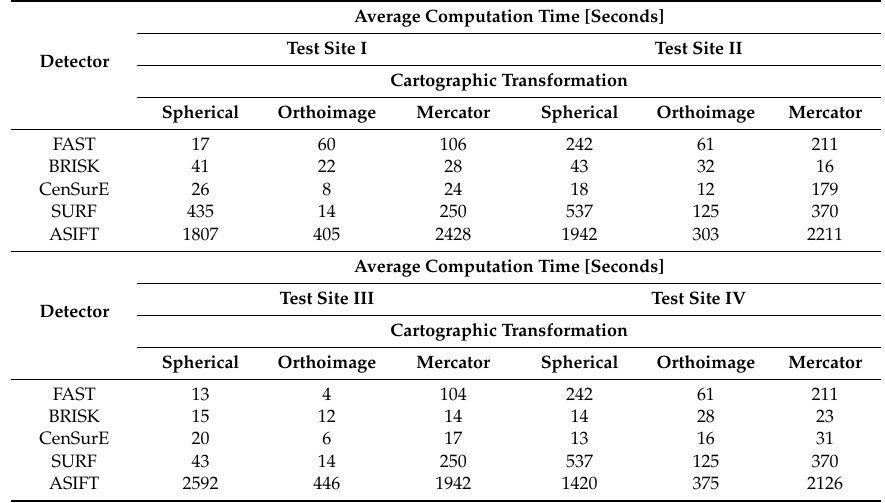
Table 1. Time taken for detection and matching of characteristic points for particular projections of point clouds, for all test sites.